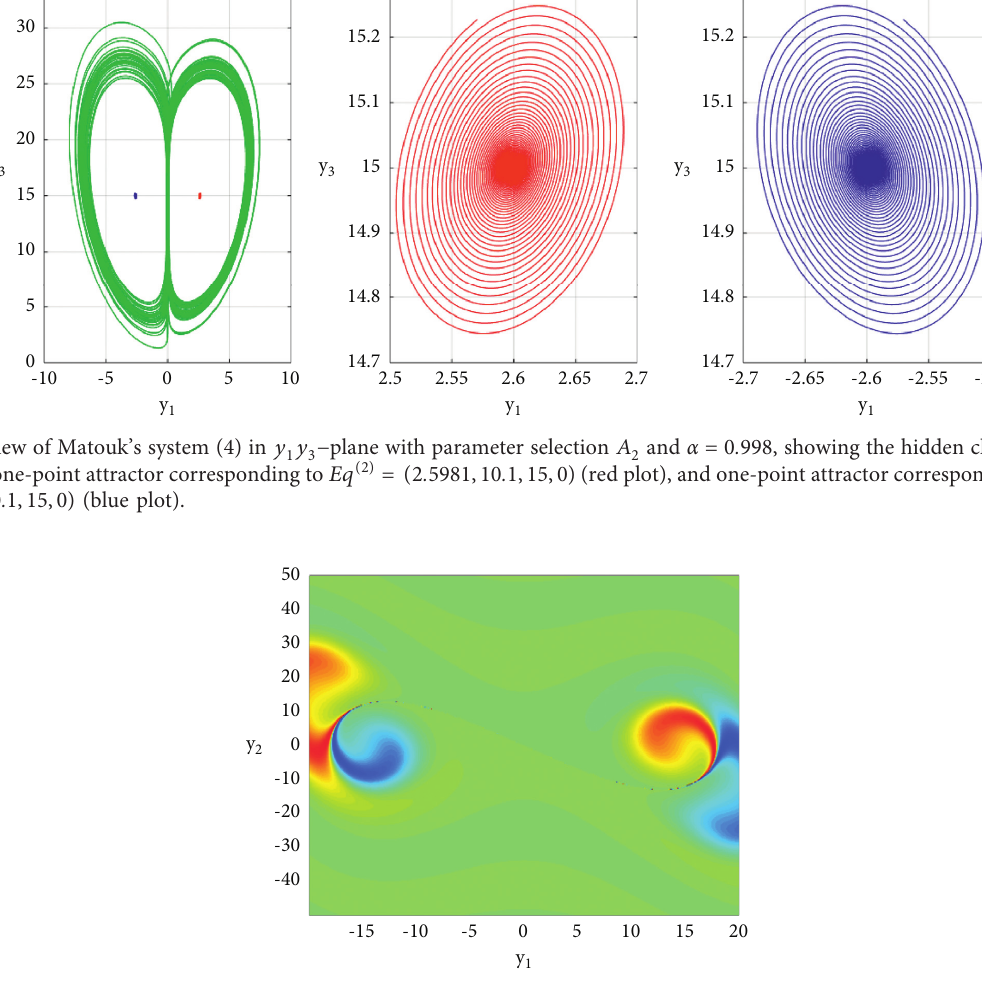
Figure 12: A cross section for y � 0and y � 0 of three colored basins of attraction for the hidden chaotic attractor (green), the equilibrium 3 4 Eq ( 2 ) (orange), and the equilibrium Eq ( 3 )